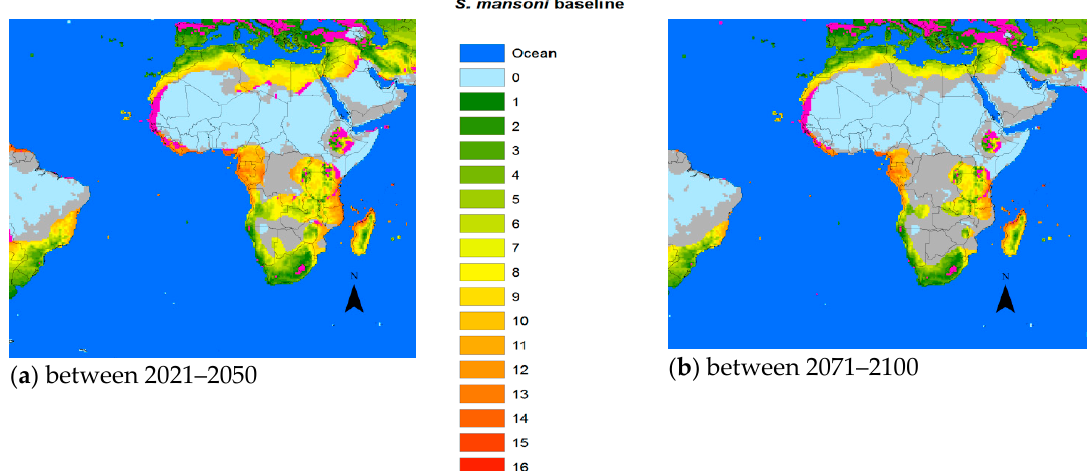
Figure 3. Change of risk area for S. mansoni vs. the baseline. ( a ) 2021–2050 vs. the baseline, ( b ) 2071–2050 vs. the baseline.